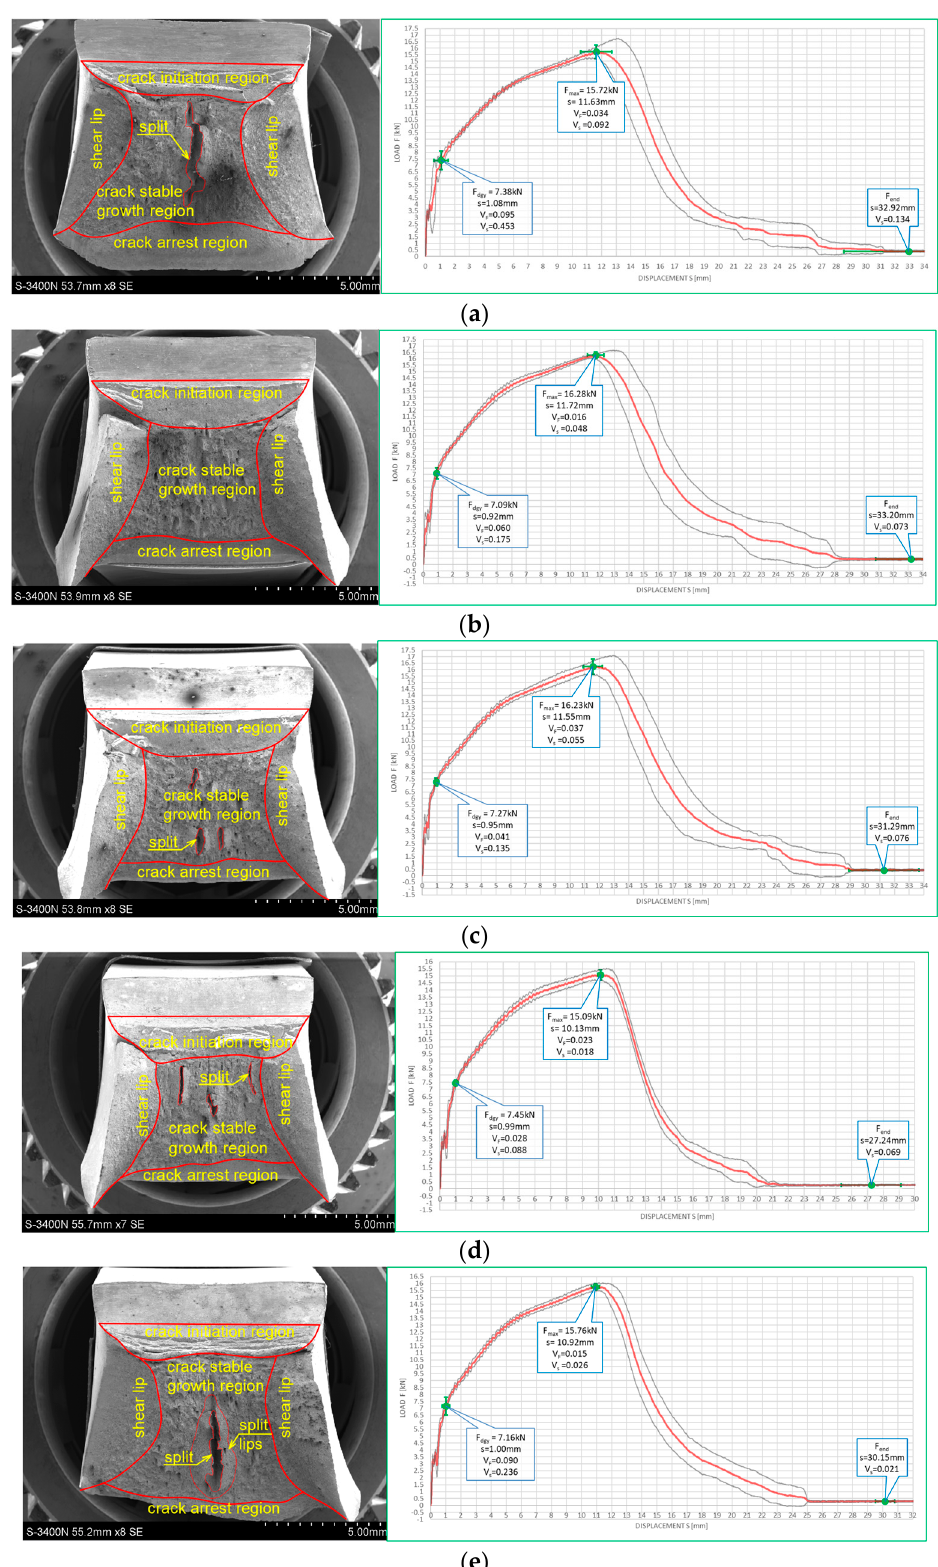
Figure 19. Morphology of the impact fractures obtained during the tests conducted at − 20 °C on the samples made of X6CrNiTi18-10 steel—denotations follow the key listed in Table 1. ( a ) 2 ( − 20) ; ( b ) 260 ( − 20) ; ( c ) 261 ( − 20) ; ( d ) 280 ( − 20) ; ( e ) 281 ( − 20) .